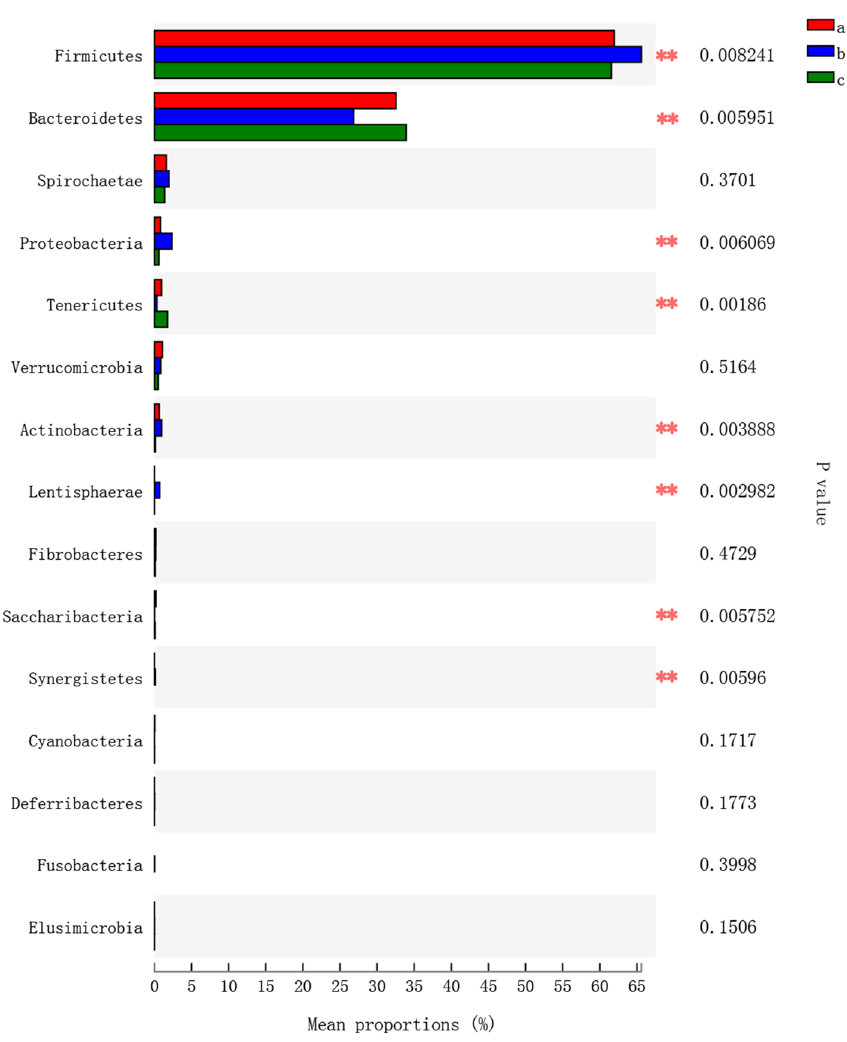
Figure 6. Statistical analysis of dominant phyla in faeces. a: Feeding period, b: fasting period, c: recovery feeding period. Statistical analysis was performed by one-way ANOVA with Tukey’s multiple comparison post- test, *0.01 < P ≤ 0.05, ** 0.001 < P ≤